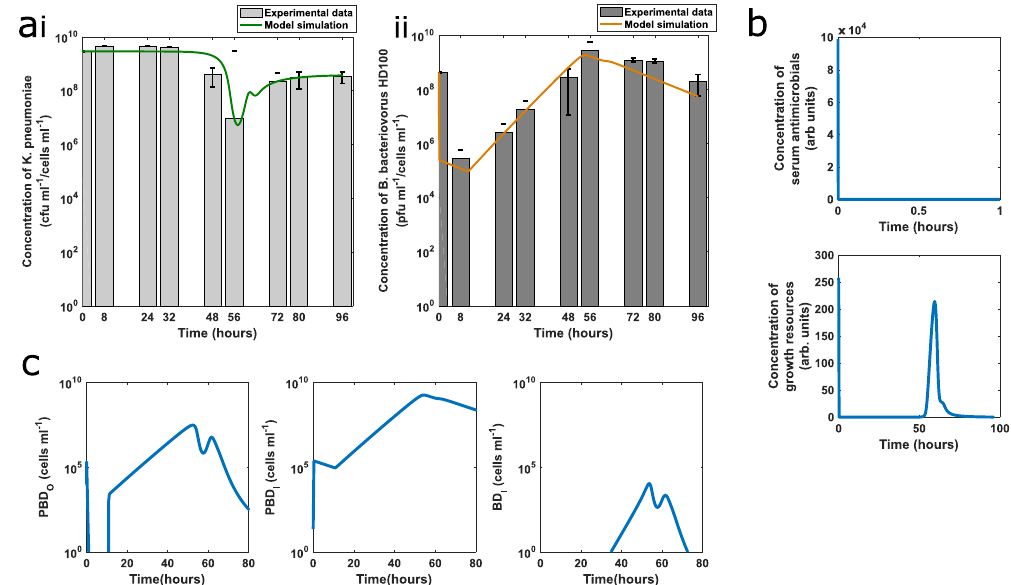
Figure 6. Model simulations of predation in human serum in comparison to experimental data, validating parameters estimated. (a) Model simulations with the best fit parameters (given in Supplementary Table S2) give a good fit to experimental data (mean of experimental repeats 1 and 2 from Fig. 5), with comparable dynamics. The drop in prey concentration due to predation and corresponding rise in predator numbers seen in the experimental data is replicated in the numerical simulation ( b) The predators attached to prey (PBD O ), predators inside prey i.e. bdelloplast (PBD I ) and inactivated predators (BD I ) are shown plotted against time. All three plots show a halting of predation for the first approximately 15 hours, then a continuing of the predatory cycle. By around 56 hours all the prey have become resistant. (c) The simulated serum antimicrobial concentrations showed that the antimicrobial activity of the serum is used up quickly (within the first 10 minutes of the simulation). Initial serum growth resources in the simulation are also quickly depleted, but an increase in growth resources is seen after 50 hours as lysis of bdelloplasts starts to release nutrients into the system.